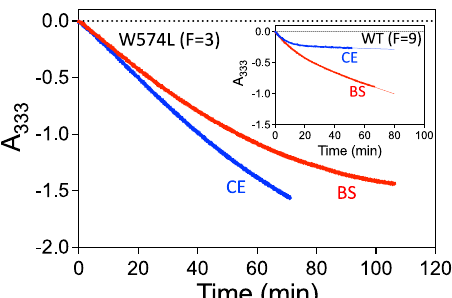
Fig. 6 Progress curves for the accumulative inhibition of W574L and WT At AHAS by CE and BS. In WT At AHAS (inset), CE promotes a stronger level of accumulative inhibition than BS. However, in the W574L mutant, the presence of CE accumulative inhibition is virtually abolished. In contrast, BS still can promote accumulative inhibition in the W574L mutant. F = the ratio of enzyme concentration vs inhibitor concentration. Source data are provided with the